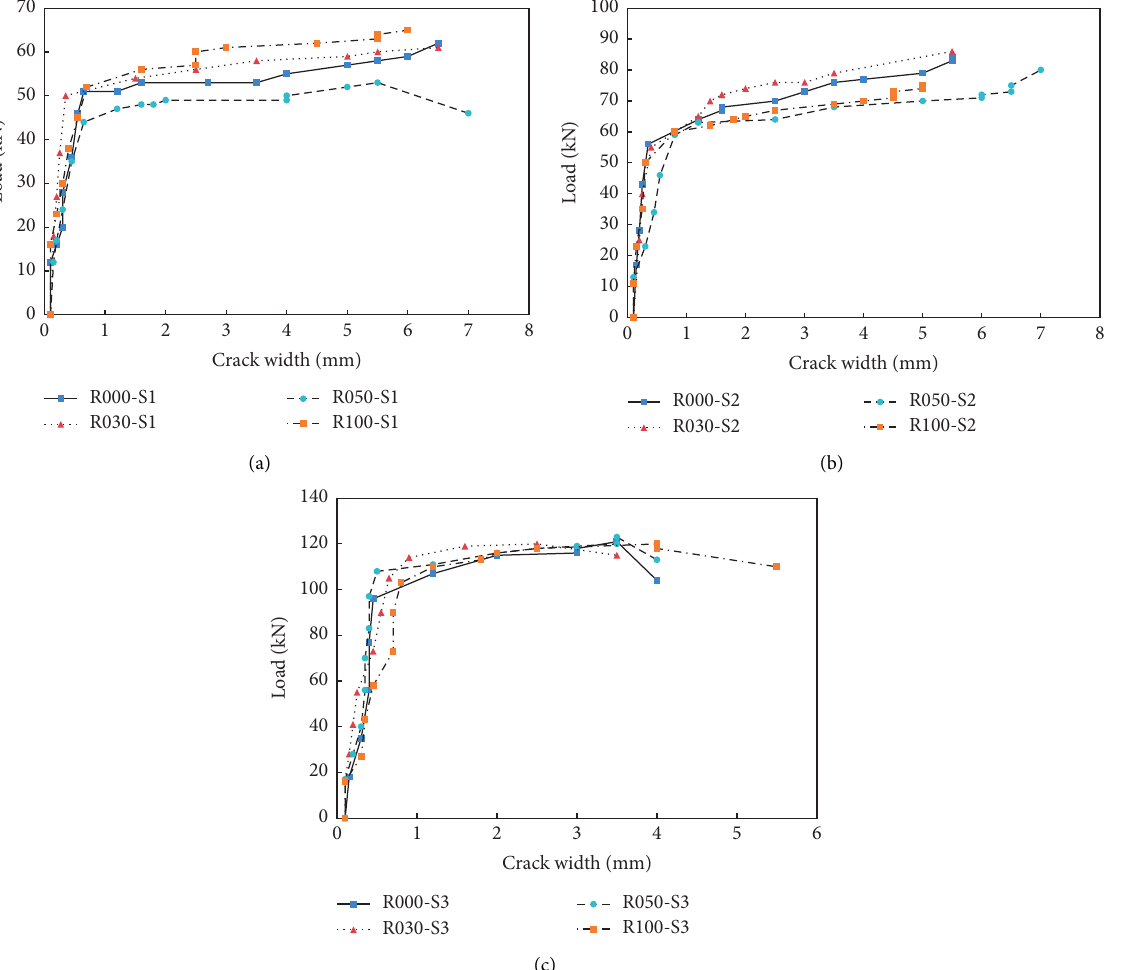
Figure 8: Load versus crack width. (a) S1 series beams (rebar ratio of 0.50%). (b) S2 series beams (rebar ratio of 0.79%). (c) S3 series beams (rebar ratio of